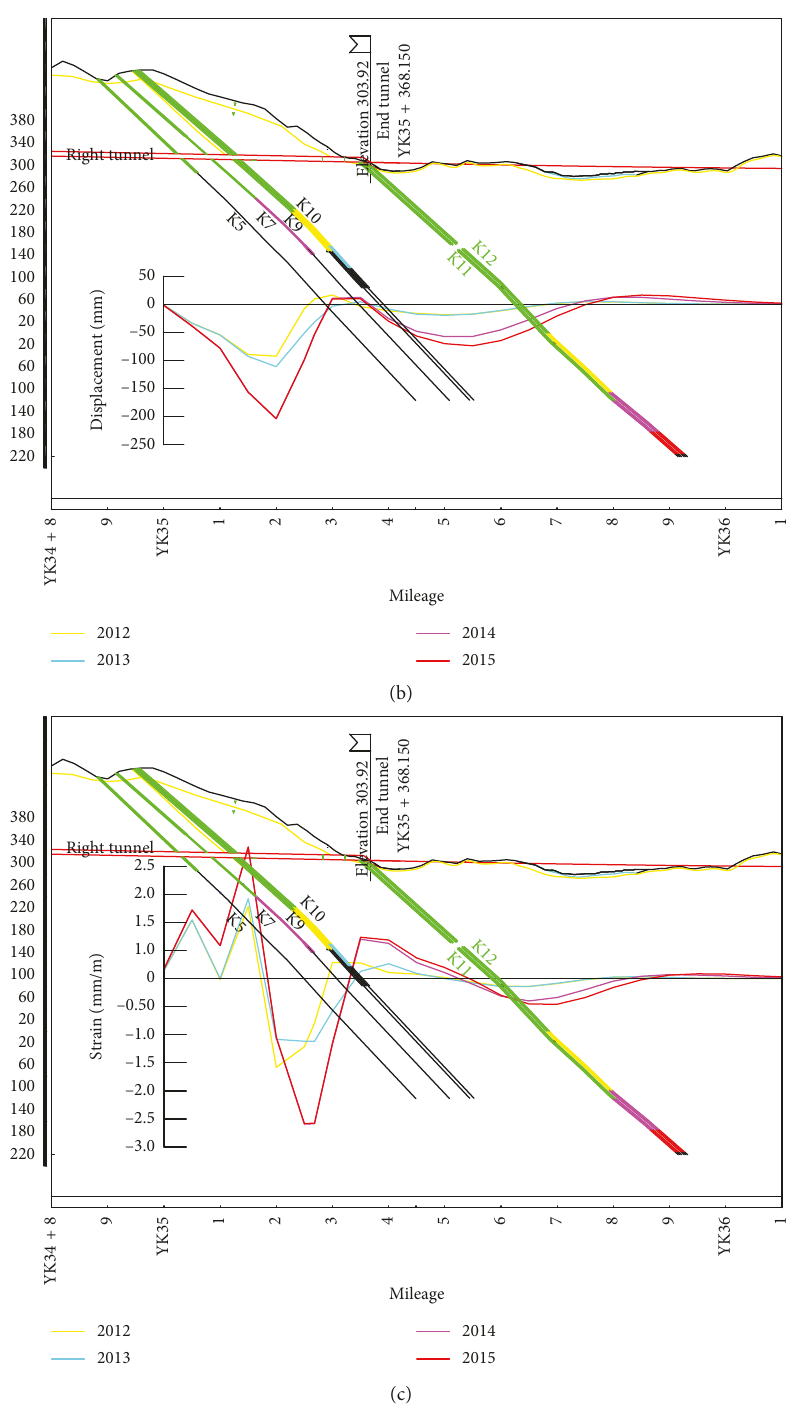
Figure 15: The right tunnel deformation. (a) Subsidence. (b) Displacement. (c) Normal strain along the